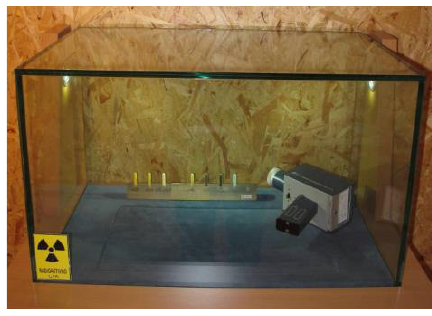
Fig. 5. Samples of uranium compounds.